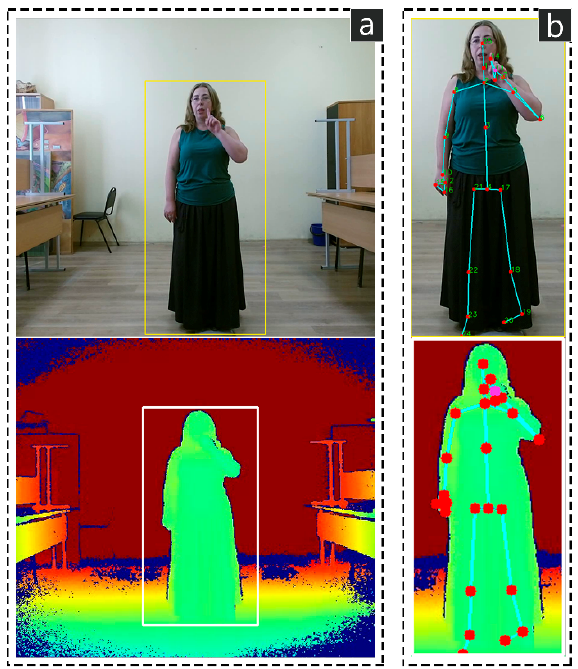
Figure 4. An example of calculating the 3D and 2D 25 reper- dots model of the skeleton for each person